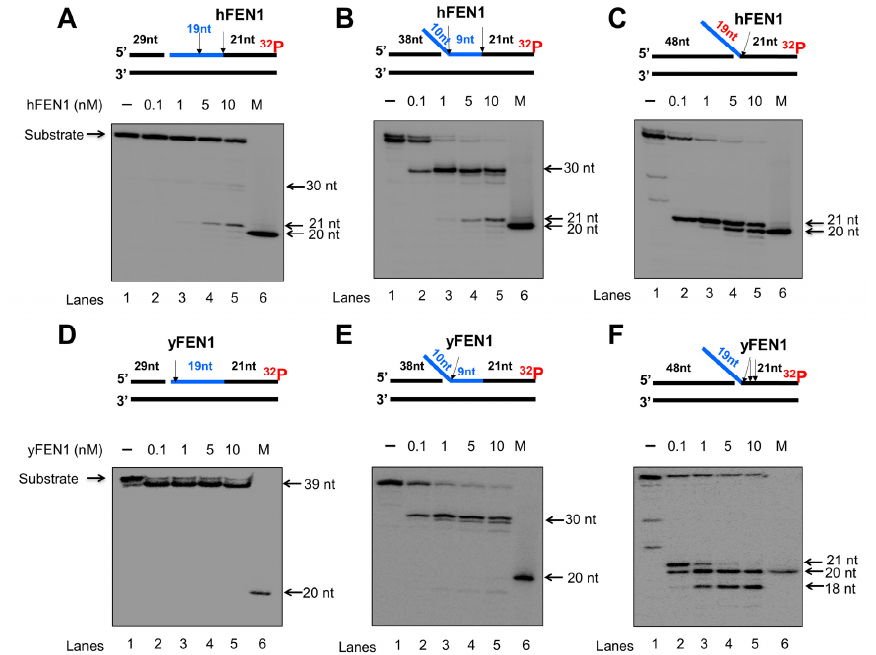
Figure 2. FEN1 exonucleolytic cleavage of RNA:DNA hybrids. Human and yeast FEN1 exonucleo- lytic cleavage activity on the RNA strand in the context of RNA/DNA hybrids was measured by incubating various concentrations of FEN1 (0.1–10 nM) with the substrates (25 nM) at 37 °C for 30 min. Substrates were 32 P-labeled at the 3 ′ -end of the downstream DNA strand containing a RNA (blue). ( A ) Human FEN1 cleavage on the RNA on the substrate containing a nicked RNA:DNA hybrid. ( B ) Human FEN1 cleavage on the substrate containing a 9 nt-RNA flap of generated from a RNA:DNA hybrid. ( C ) Human FEN1 cleavage on the substrate containing a 19 nt RNA flap attached to a duplex DNA. ( D ) Yeast FEN1 cleavage on the substrate containing a nicked RNA:DNA hybrid. ( E ) Yeast FEN1 cleavage on the substrate containing a 9 nt-RNA flap generated within RNA:DNA hybrid. ( F ) Yeast FEN1 RNA cleavage on duplex DNA containing a 19 nt-RNA flap. Lane 1 repre- sents substrate only. Lanes 2–6 represent the reaction mixture with increasing concentrations of FEN1. “M” represents a size marker of 20 nt. Substrates and products were separated in a 15% urea- denaturing polyacrylamide gel and detected by phosphorimager. The experiments were performed in triplicate.